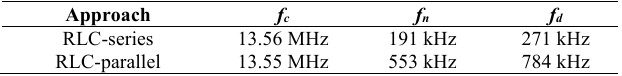
TABLE III. Canonical Form VTF Parameters